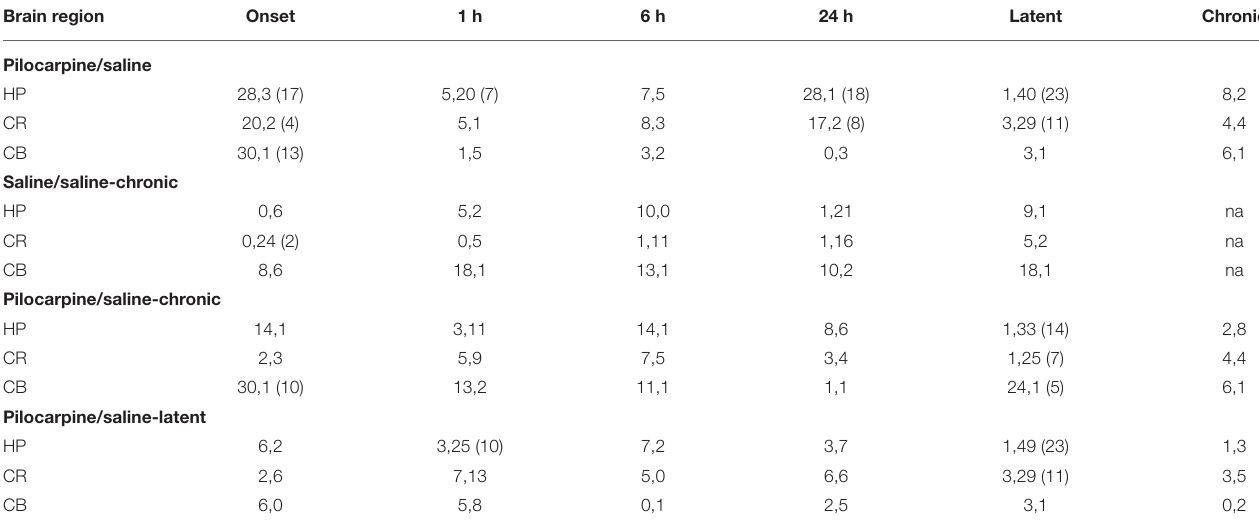
TABLE 1 | Summary of protein expression changes. Brain